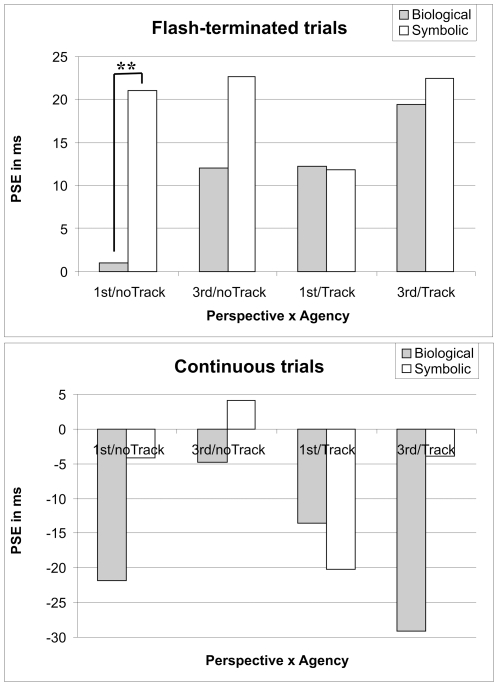
Flash-terminated and continuous trials.The x-axis shows the four combinations of perspective (1st vs. 3rd person) and agency (tracking vs. no tracking). The y-axis expresses the PSE in ms. A) The positive values in the flash-terminated trials reveal that we did not observe an FLagE (negative values) but a flash-lead effect (FLeadE, positive values) in the flash-terminated conditions due to the nature of our stimuli (see Methods). However, the condition that generates the strongest motor resonance (biological, 1st person perspective), yet without the illusion of control (no tracking) shows the smallest FLeadE (i.e., more of an FLE than the other conditions). Two asterisks indicate p<.01. B) Predominantly negative values are observed in the continuous motion conditions. Further explanations in the text.